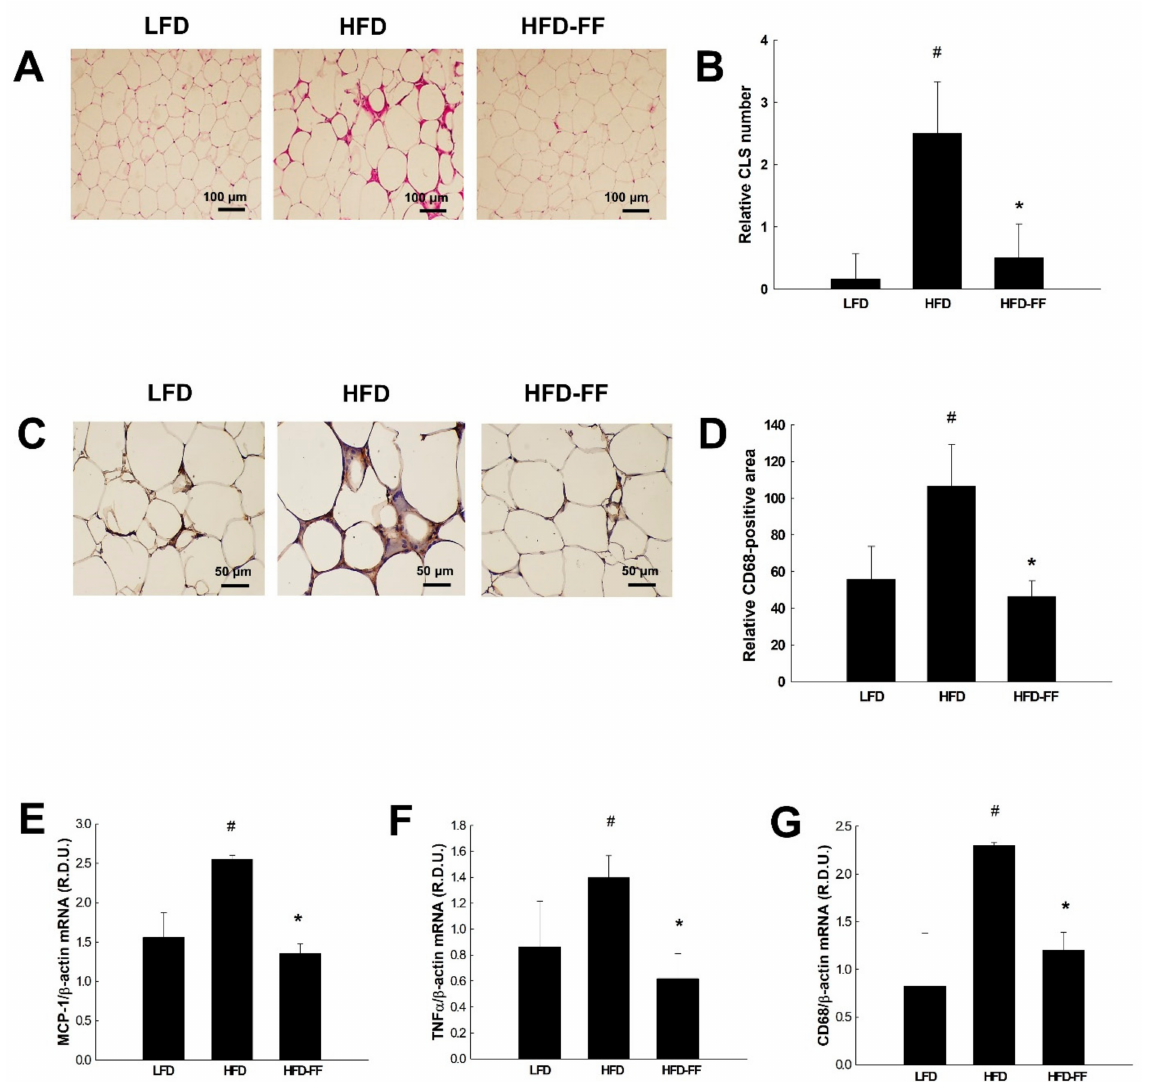
Figure 6. Effects of fenofibrate on visceral adipose tissue inflammation in HFD-fed female OVX mice. OVX C57BL/6J mice were fed an LFD, an HFD or an HFD supplemented with fenofibrate (HFD-FF, 0.05% w / w ) for 21 weeks. ( A ) Hematoxylin and eosin-stained CLS of visceral adipose tissues (original magnification × 100). ( B ) Relative CLS number. ( C ) Immunohis- tochemical detection of CD68-positive macrophages in visceral adipose tissues (original magnification × 200). ( D ) Relative CD68-positive area. The mRNA expression of ( E ) MCP-1, ( F ) TNF α , and ( G ) CD68 in visceral adipose tissues. All values are expressed as mean ± SD ( n = 8/group). # p < 0.05 compared with LFD, * p < 0.05 compared with HFD. CLS, crown-like structures; MCP-1, monocyte chemoattractant protein 1; TNF α , tumor necrosis factor α